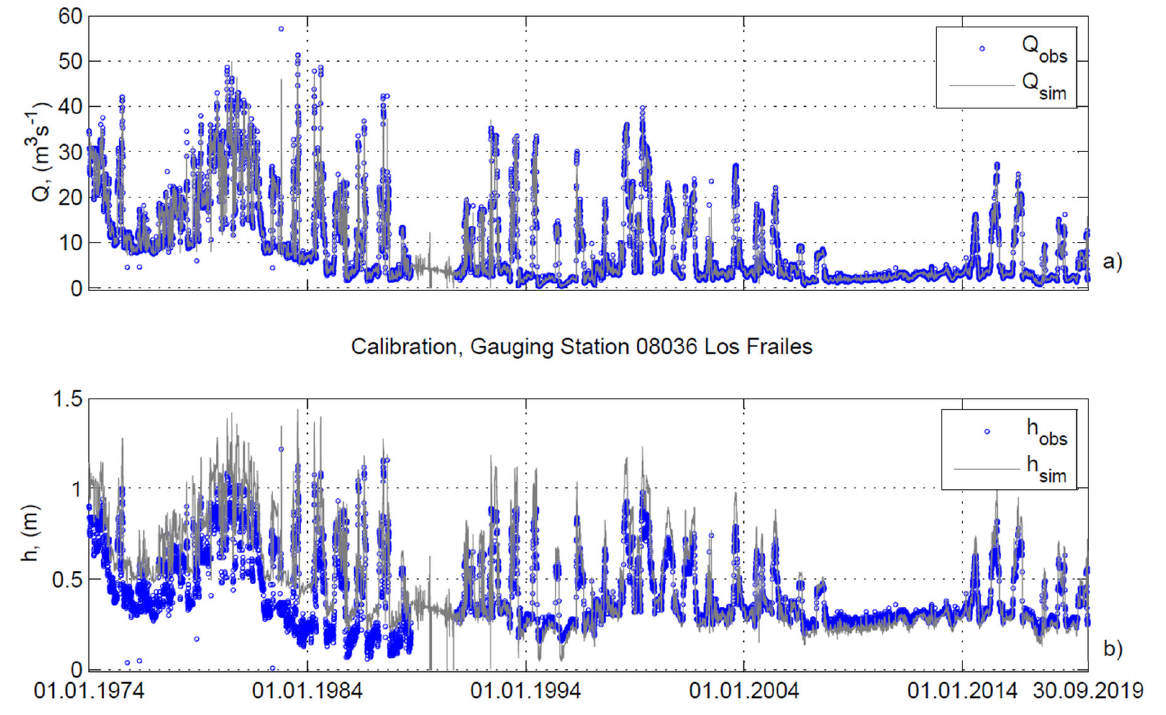
Figure 5. Simulated and observed time series. Daily mean observed (blue dots) and modeled (gray line) time series for water discharge ( a ) and depths ( b ) at Los Frailes gauging station within the time periods with available data, used for the model performance evaluation. The exact time periods can be found in Table 3. Table 3. Calibration and validation statistical performances at Los Frailes and Puente de Carrasco stations (simulated versus observed time series), represented by correlation coefficient (R), deter- mination coefficient (R 2 ), Nash–Sutcliffe efficiency (NSE), and root mean square error (RMSE) for discharge Q (m 3 s − 1 ) and depths h (m) time series, calculated within periods with availability for observed